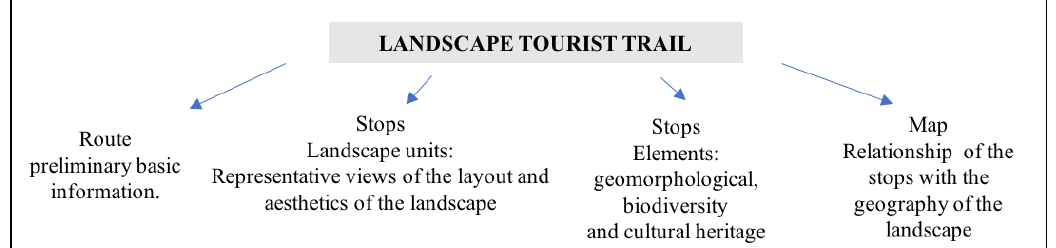
Figure 1. Sources, resources, and methodology of the natural landscape study. Source: self-elaboration. The proposed landscape trail will follow a route that runs around the perimeter of the eruptive centres of Chinyero and has been designed with different stops for exploration and interpretation of the landscape units and elements of their natural and cultural heritage (Figure 2).